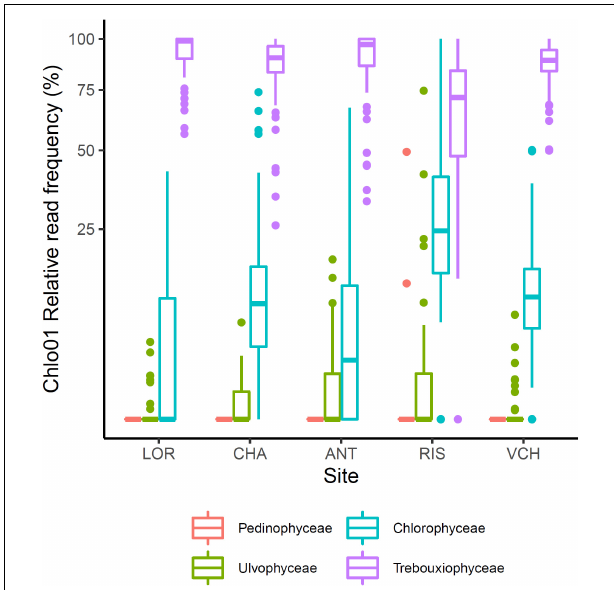
FIGURE 6 | Distribution of the four taxonomic classes of Chlorophyta . Trebouxiophyceae and Chlorophyceae are the two main clades. Pedinophyceae just occurs sporadically in two PCRs on the RIS gradient. FIGURE 8 | Redundancy analysis (RDA) of the Chlorophyta community